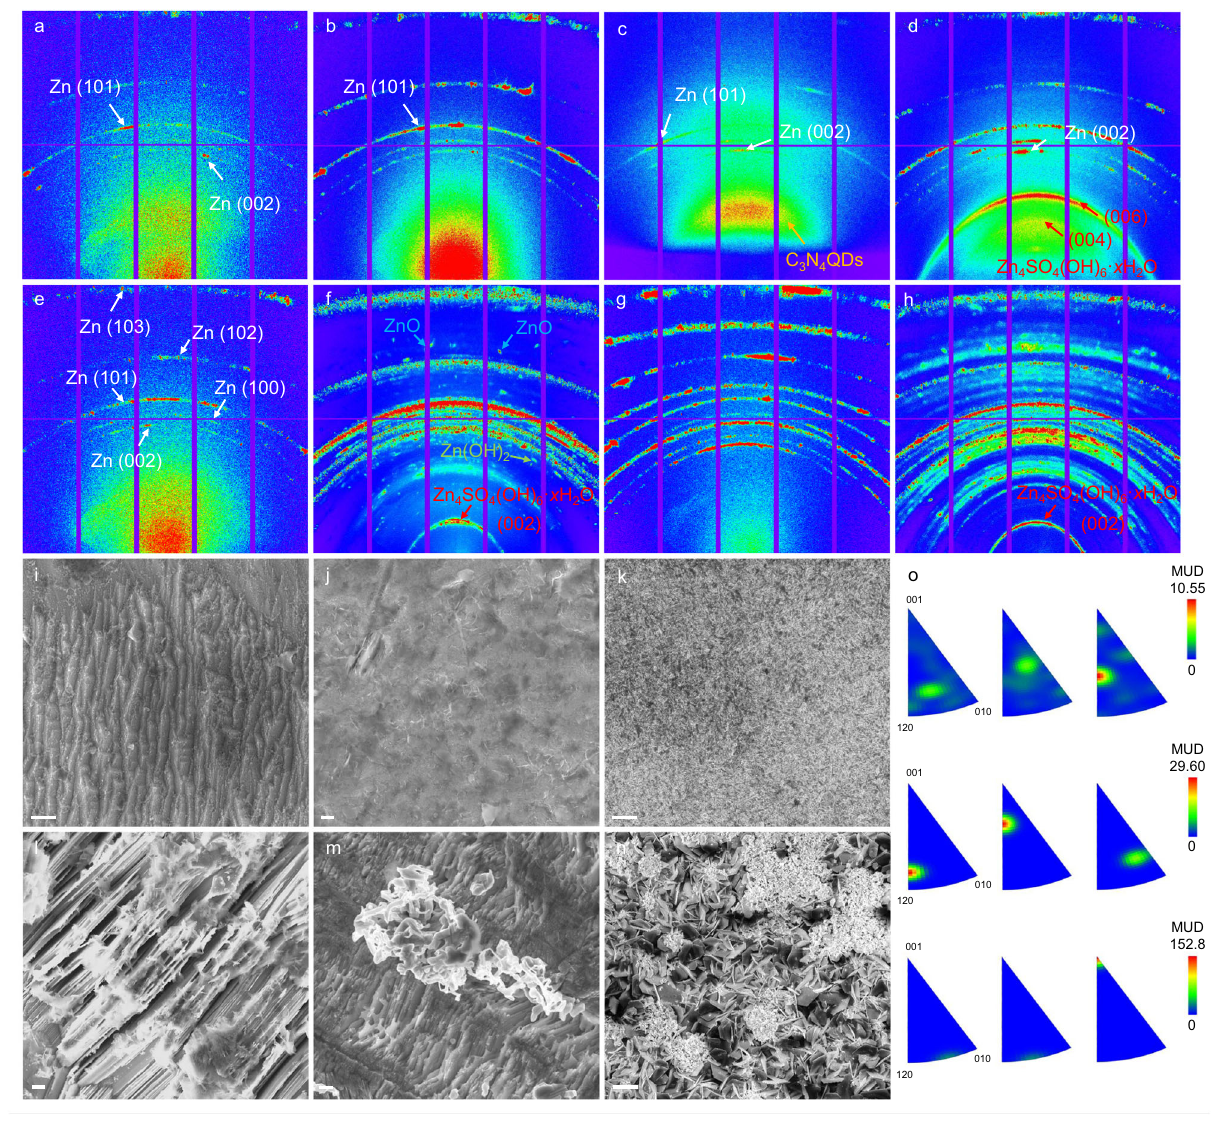
Fig. 4 | Texture formation ofZn anodes. 2D synchrotron grazing-incidence X-ray diffraction (GIXD) patterns of a , c , e , g Zn@ZnSO 4 -C 3 N 4 QDs and b , d , f , h Zn@ZnSO 4 after1ststripping,1st,15th,and75thstripping/platingprocess under the current density of 1mAcm − 2 with a capacity of 1mAhcm − 2 ;